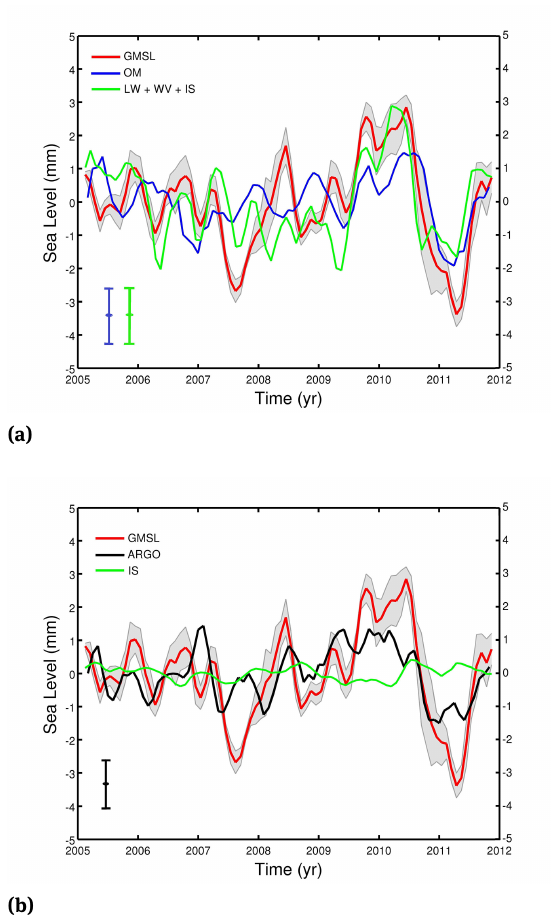
Fig. 4. a) Interannual GMSL (red curve) on which is superimposed the sum of the mass (from GRACE) and steric contribution from Argo (light blue curve). The vertical bar represents the error on monthly values of the sum of mass and steric contributions; Interannual GMSL (red curve) on which is superimposed the sum of the mass (sum ‘land water storage + water vapor + interannual ice sheet component’) and steric contribution from Argo. The vertical bar represents the error on monthly values of the sum of mass and steric